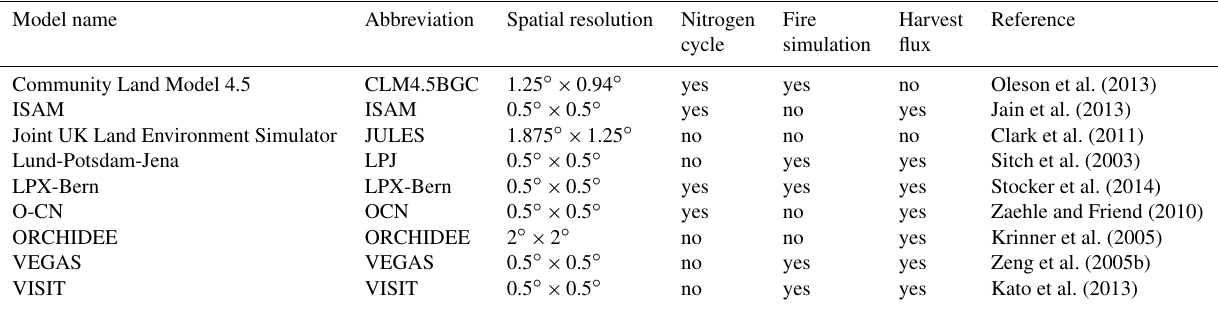
Table 1. Basic information for the nine TRENDY models used in this